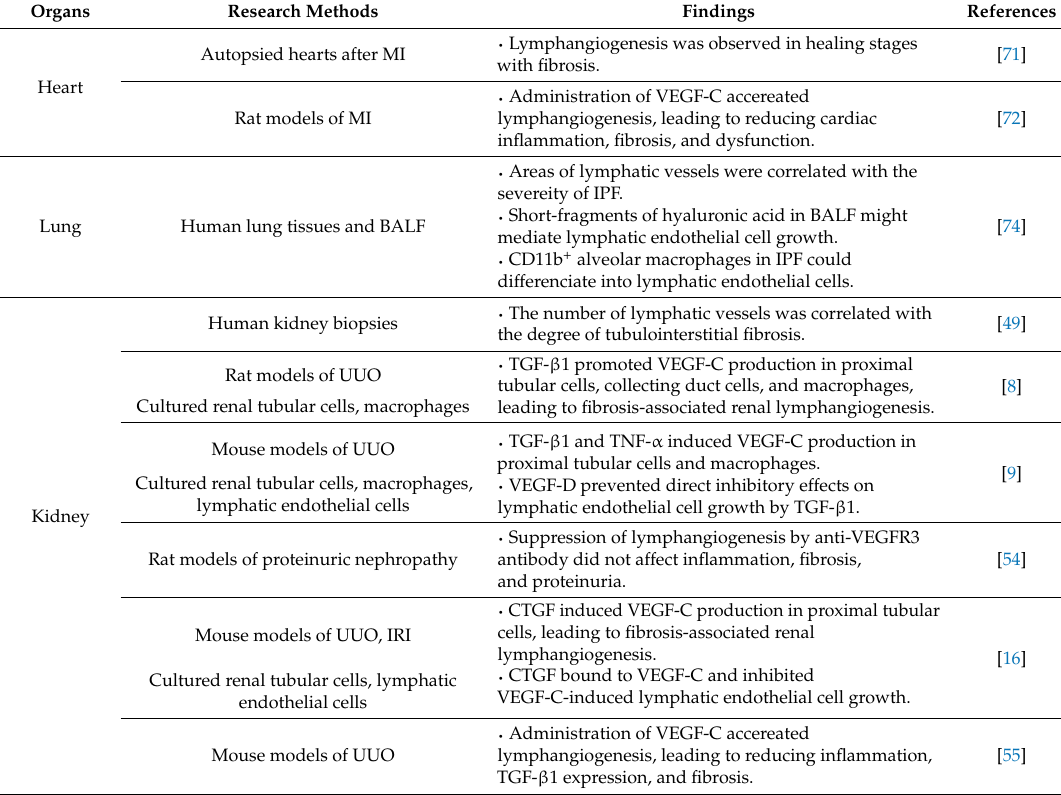
Table 1. Lymphangiogenesis in fibrotic diseases.